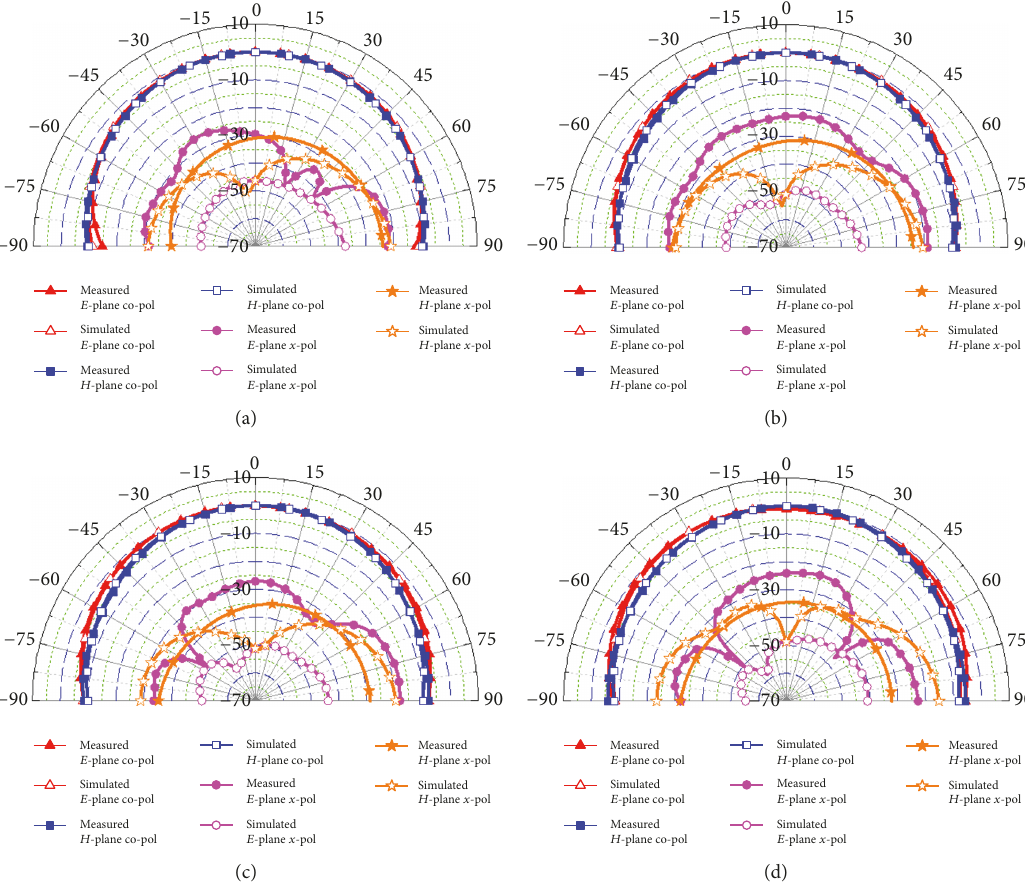
Figure 12: The simulated and measured normalized radiation patterns of the antenna in Figure 9(a) with 4 × 6 HIS array: (a) 0.55 GHz, (b) 0.60 GHz, (c) 0.65 GHz, and (d) 0.70